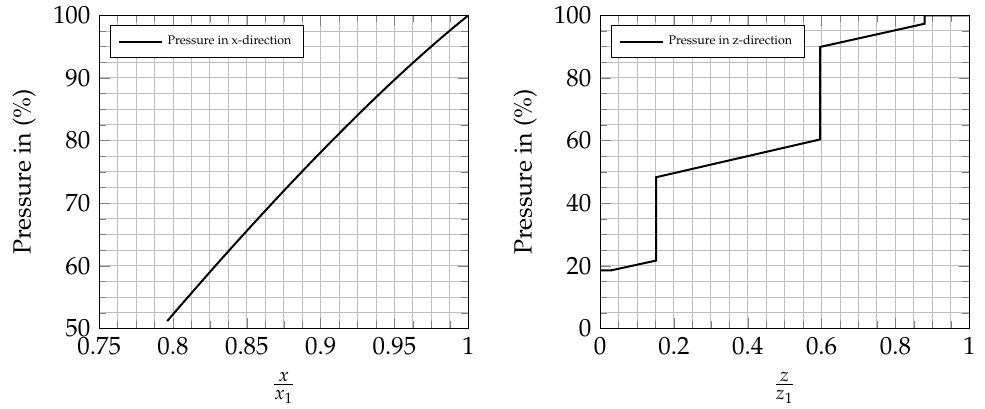
Figure 20. Pressure function at the runner hub in x , z -direction of hydropower plant 2.